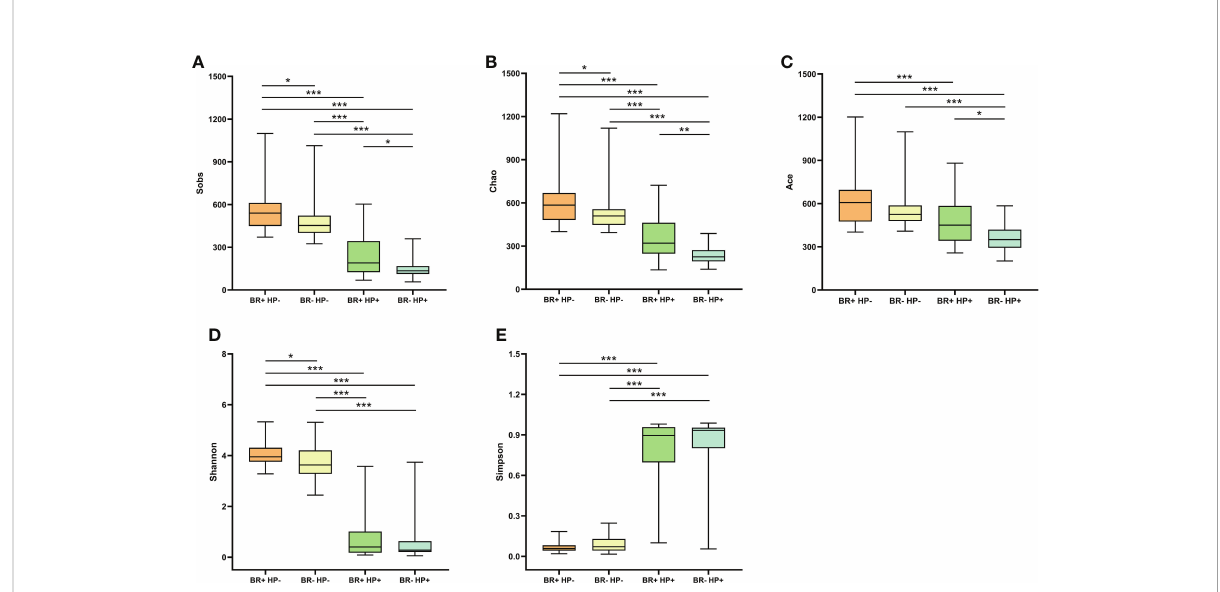
FIGURE 2 Alpha diversity of the gastric microbiota in the BR+ HP-, BR- HP-, BR+ HP+, and BR- HP+ groups. The Wilcoxon rank-sum test was used to compare the Sobs (A) , Chao1 (B) , Ace (C) , Shannon (D) , and Simpson (E) indices between the groups. *, P < 0.05; **, P < 001; ***, P < 0.001.